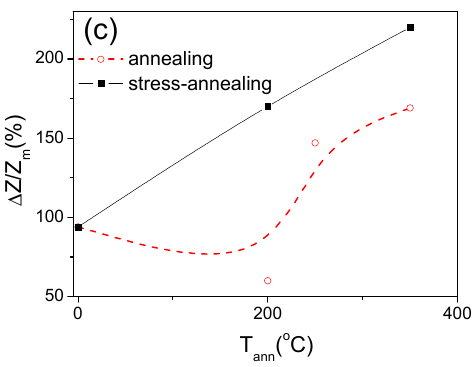
Figure 8. ∆ Z / Z m (f) dependencies evaluated for annealed and stress-annealed samples at T ann = 200 ◦ C ( a ) and T ann = 350 ◦ C ( b ) and ∆ Z / Z m (T ann ) dependence ( c ) evaluated for f = 150 MHz for annealed and stress-annealed samples. The lines are just to guide the eyes.